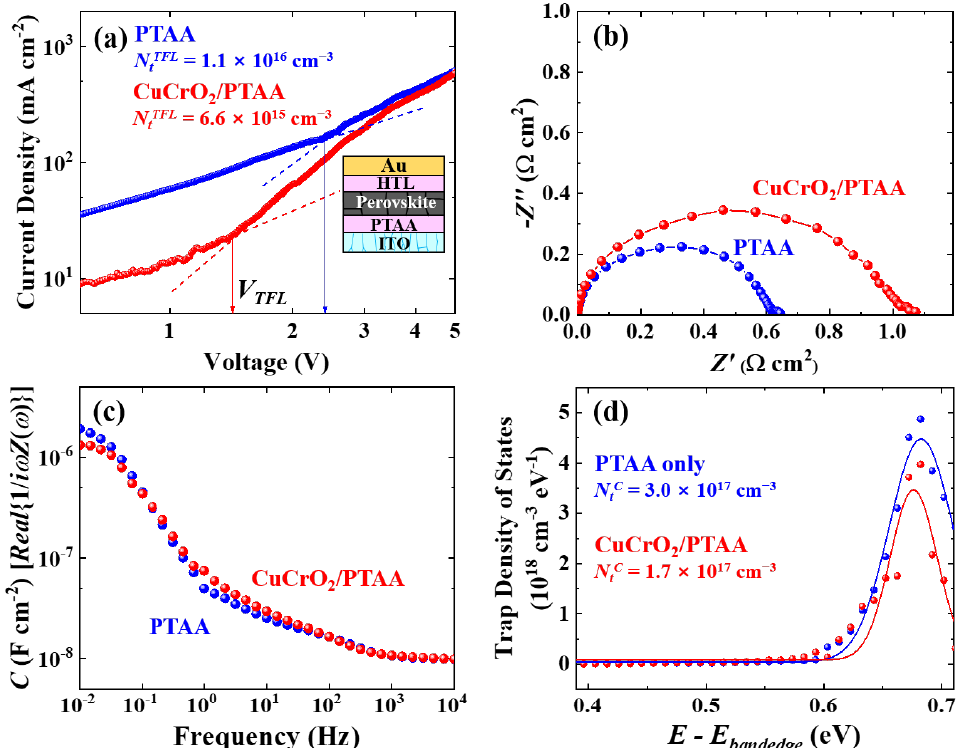
Figure 3. Trap density analyses of devices with different HTLs: ( a ) Dark J-V characteristics of hole- only devices with different upper HTLs, and calculated trap densities (N tTFL ) from trap-filled limited voltages (V TFL ); ( b ) Nyquist plot, ( c ) capacitance-frequency plot, and ( d ) trap density of states obtained from the capacitances (with the integrated trap density N tC ), in the device structure of ITO/SnO 2 /perovskite/HTL/Au.